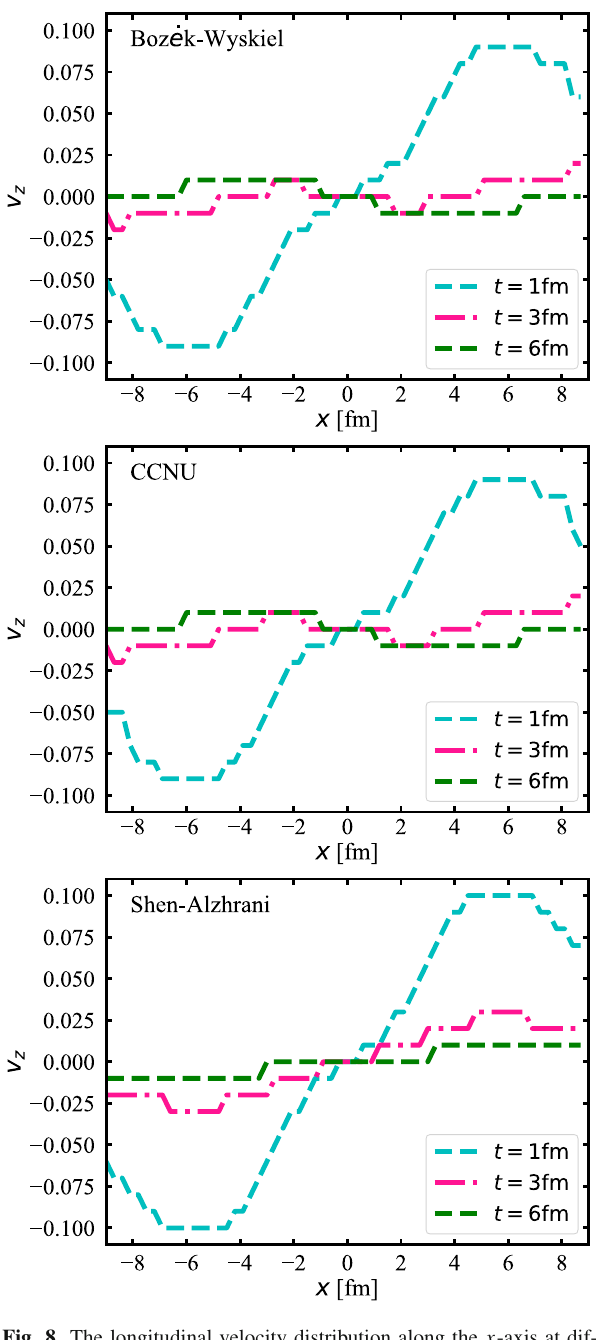
Fig. 8 The longitudinal velocity distribution along the x -axis at dif- ferent times. Results from three different initial condition setups are presented in the three panels